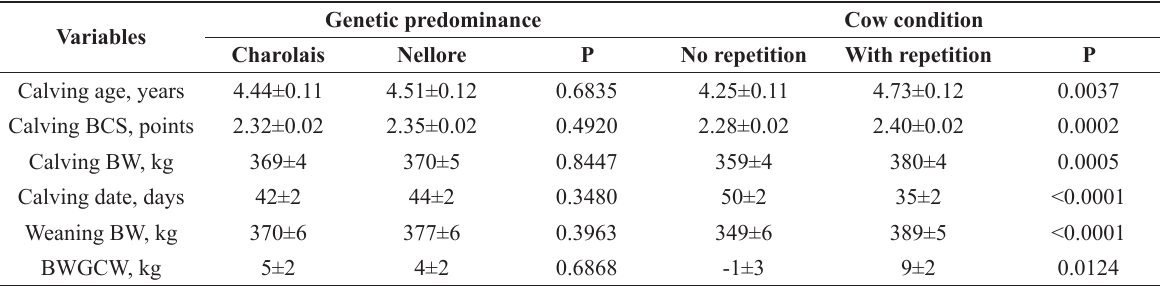
Mean and standard error of age of cow at calving, body weight (BW) and body condition score (BCS) at calving, calving date at calving season, body weight at weaning, and body weight gain from calving at weaning (BWGCW) from cows of the evaluated